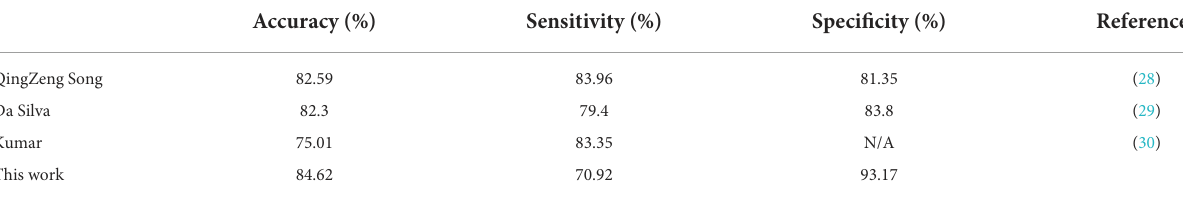
TABLE 6 Comparison with existing